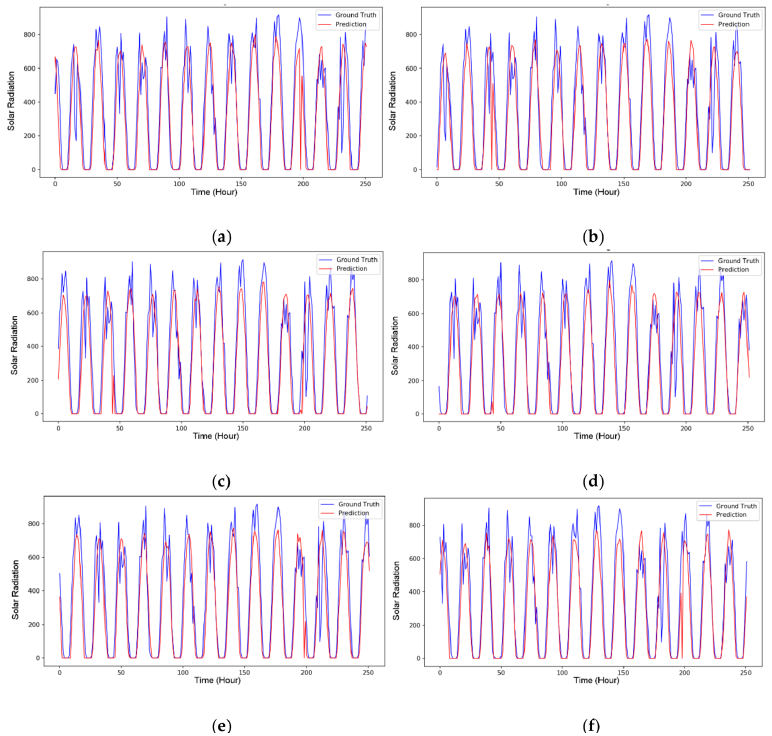
Figure 14. Forecasting results of the proposed SolarNet: ( a ) Partial results A; ( b ) Partial results B; ( c ) Partial results C; ( d ) Partial results D; ( e ) Partial results E; ( f ) Partial results F. Table 1. Experimental results in terms of Mean Absolute Error